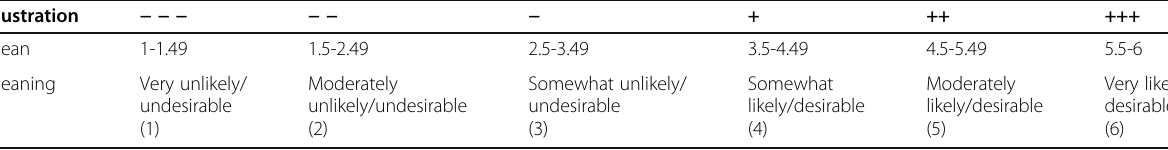
Table 2 Visualization of means